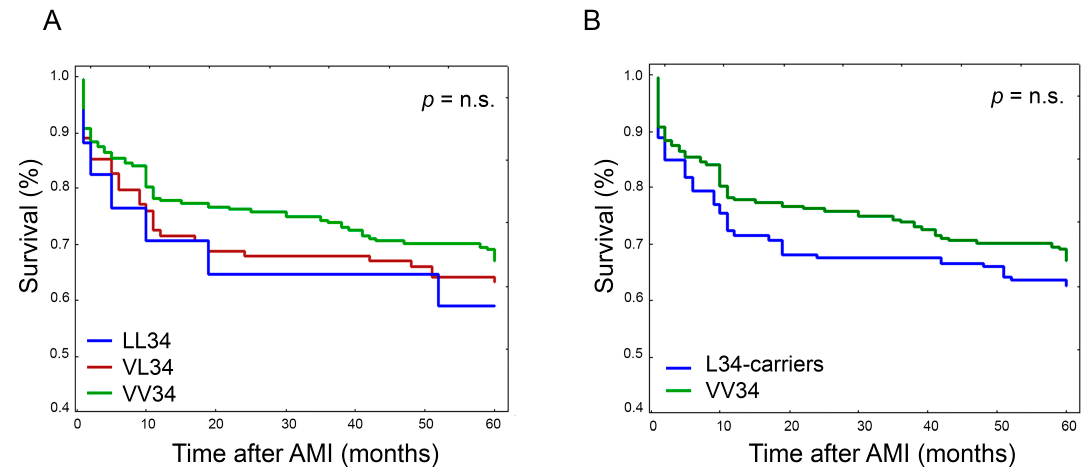
Figure 4. Plots of Kaplan-Meier survival analysis estimated after AMI according to FXIIIA V34L genotypes. ( A ) Survival curve comparison between LL34-homozygotes (LL34), VL34-heterozygotes (VL34), and VV34-homozygotes (VV34). Survival rate was not significantly different between the different genotypes. ( B ) Survival curve comparison between VL34-heterozygotes and LL34-homozygotes taken together (L34-carriers), and VV34-homozygotes (VV34). Survival rate was not significantly different between the two different groups of genotypes.